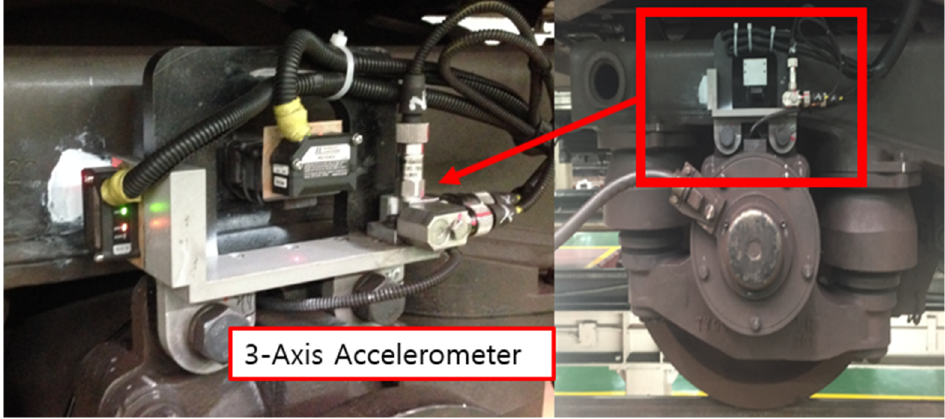
Figure 20. Location of the measuring equipment mounted on the axle box.